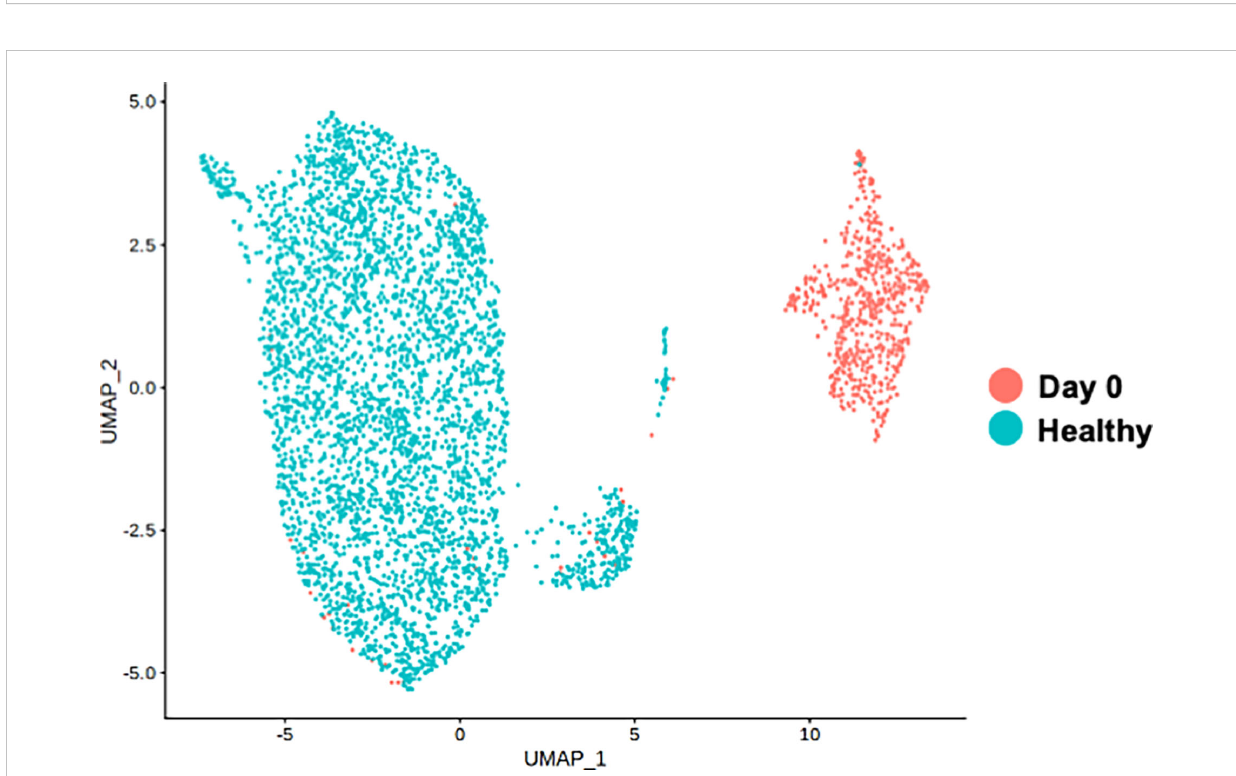
FIGURE 3 Single-cell RNA-seq analysis of classical monocyte cell population. UMAP visualization of classical monocytes colored by sample conditions. “ Day 0 ” depicts the samples obtained from the patient on day 0. “ Healthy ” depicts the samples obtained from the public healthy control data